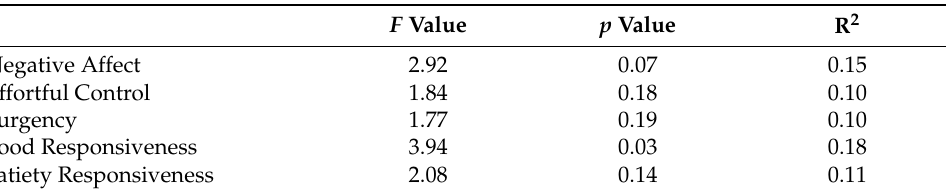
Table 1. Results examining associations between children’s candy intake group with temperament and appetite.